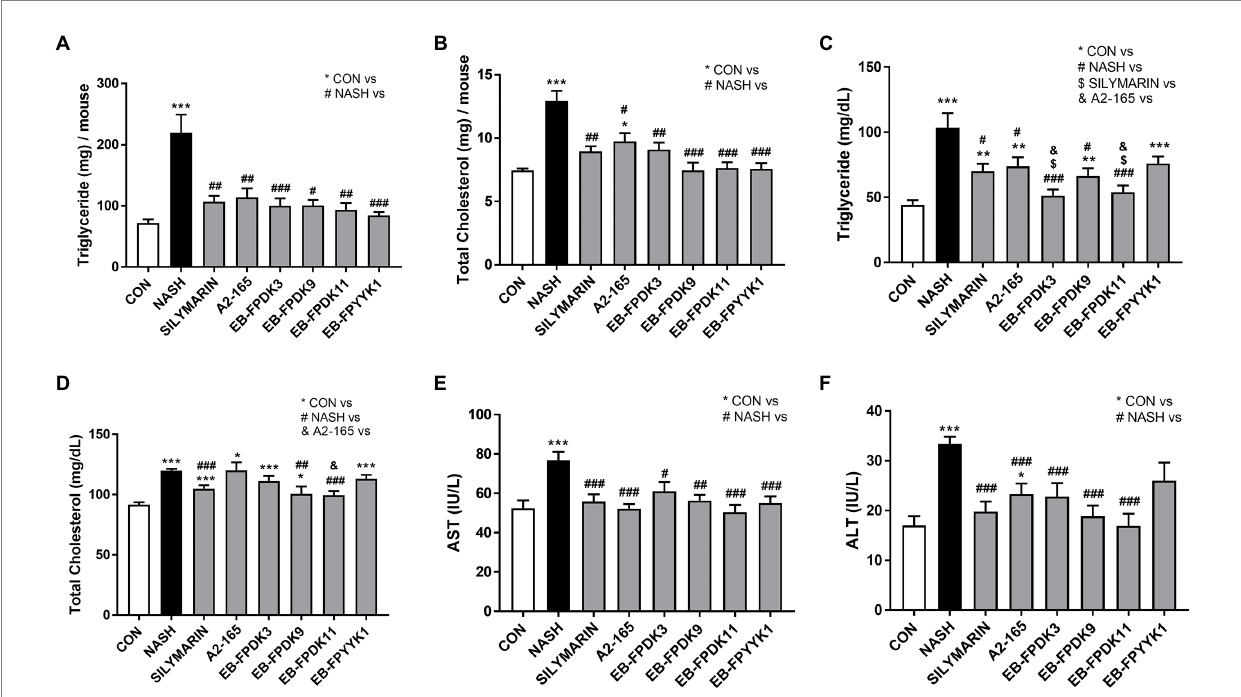
FIGURE 3 Effects of Faecalibacterium prausnitzii in preventing lipid accumulation in and damage to the liver. (A) TG and (B) TC concentrations in the liver. (C) TG and (D) TC concentrations in serum. (E) Serum AST and (F) serum ALT levels. The data are presented as the mean ± SEM ( n = 12). Statistical analyzes were performed using Kruskal–Wallis one-way ANOVA with Dunn’s test (A,B) and the Mann–Whitney U test (two-tailed) (C–F) . ∗ p < 0.05, ∗∗ p < 0.01, ∗∗∗ p < 0.001 versus the CON group; # p < 0.05, ## p < 0.01, ### p < 0.001 versus the NASH group; $ p < 0.05 versus the silymarin group; & p < 0.05 versus the A2-165 group. TG, triglycerides; TC, total cholesterol; AST, aspartate aminotransferase; ALT, alanine